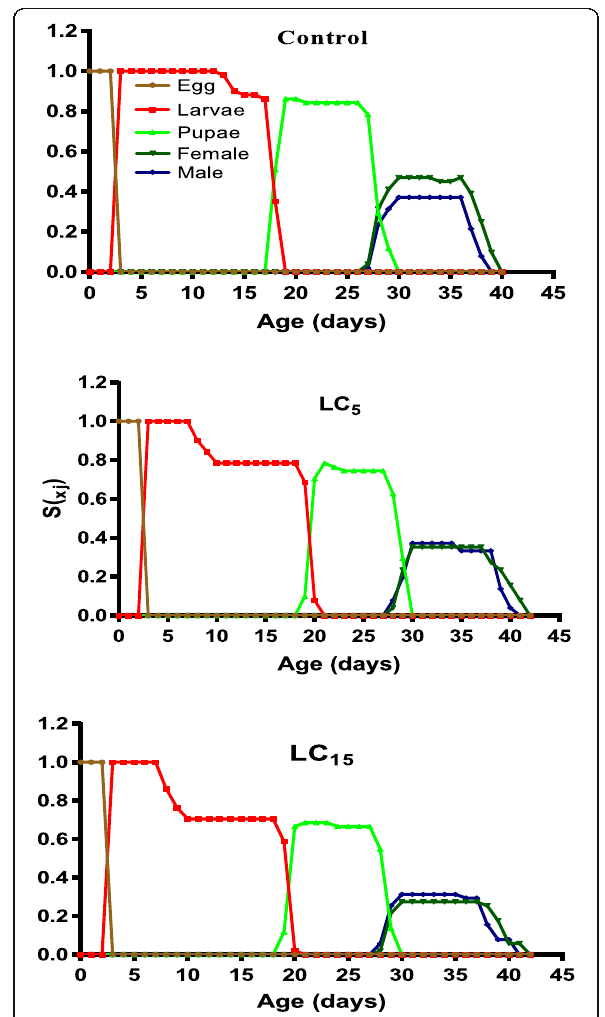
Fig. 1 Age-stage specific survival rate ( S xj ) of S. littoralis exposed to sublethal concentrations of EMB